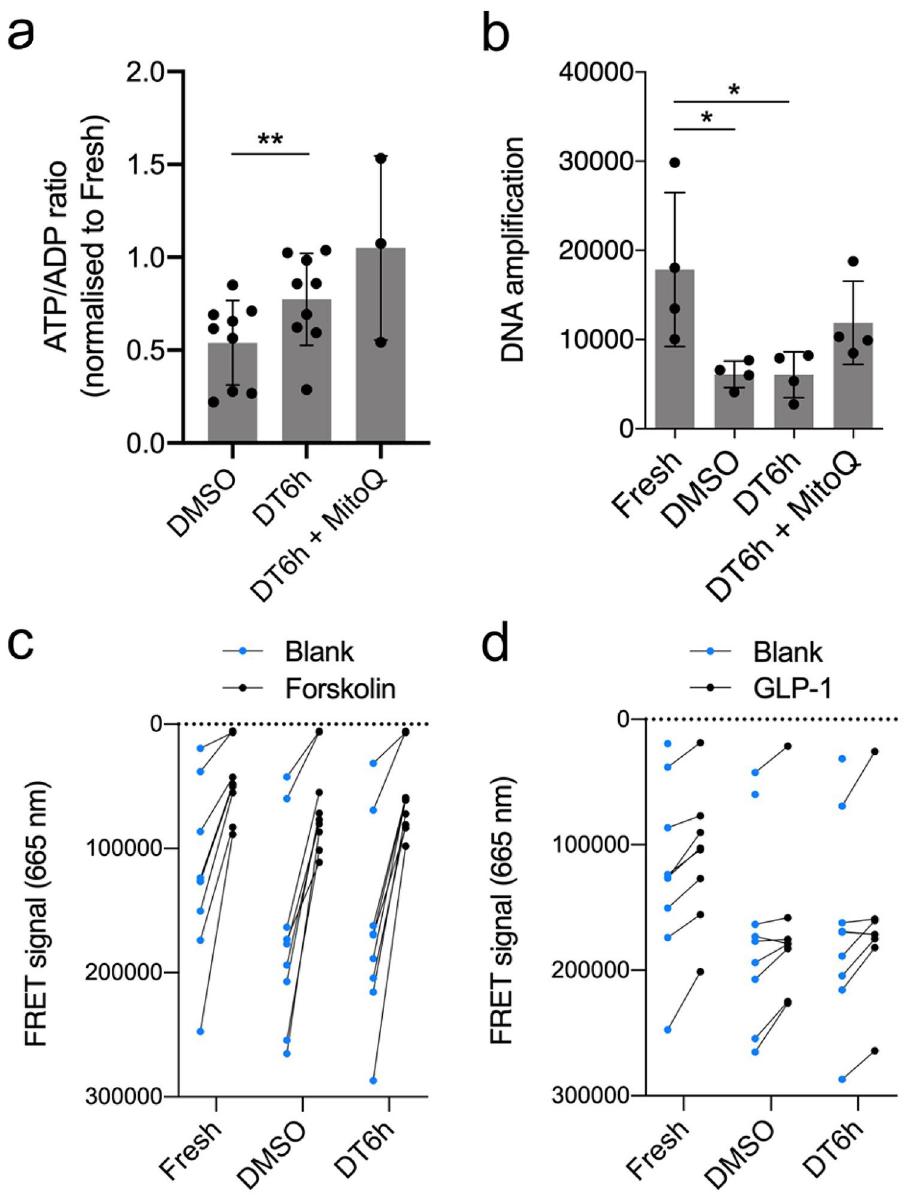
Figure 5. Metabolic data for islets cryopreserved using the proposed protocol (DT6h). ( a ) ATP/ADP ratio of cryopreserved islets 24 h post-thaw normalised to ATP/ADP ratio in fresh islets (n = 9 islet isolations). ( b ) Mitochondrial DNA oxidation levels in fresh, DMSO-cryopreserved and DT6h-cryopreserved islets. Higher amplification numbers indicate lower oxidation of mitochondrial DNA (n = 4 islet isolations). ( c ) Cyclic AMP (cAMP) production in fresh, DMSO-cryopreserved and DT6h-cryopreserved islets upon exposure to forskolin or ( d ) GLP-1. Data in ( c ) and ( d ) shown as raw values of the fluorescence resonance energy transfer (FRET) signal at 665 nm, which is inversely proportional to the cAMP concentration in the samples. Data obtained from the same islet sample are connected with a line (n = 8–9 islet isolations). Missing data were below the detection level of the assay. Repeated measures one-way ANOVA followed with Tukey’s HSD post-hoc test was performed, statistically significant differences are marked by asterisks: *p ≤ 0.05, **p ≤ 0.01. All figures were produced using GraphPad Prism (version 8.4.1, https:// www. graph pad.